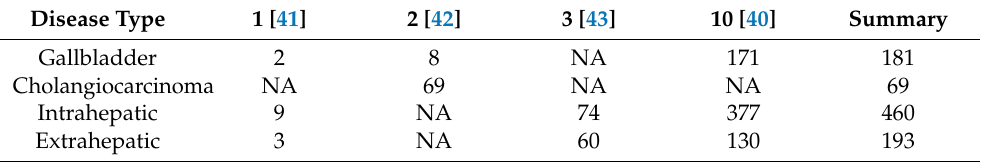
Table 5. Primary target sites of immunotherapy